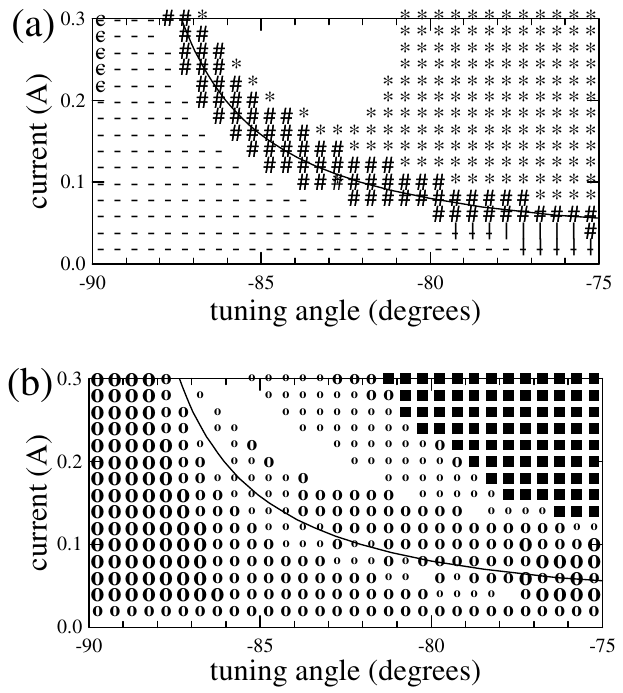
FIG. 4. Modeling for the Aladdin low-emittance lattice with worst-case parasitic coupled-bunch instability. A curve shows parameters for optimal bunch lengthening. (a) Analytic predic- tions. –: parasitic coupled-bunch instability; |: coupled-dipole Robinson instability; *: coupled-quadrupole Robinson instabil- ity; #: fast dipole-quadrupole mode-coupling Robinson instabil- ity; c: coupled-bunch instability with longitudinal mode number of 1. (b) Results of 500 000-turn simulations of 60 000 macro- particles. o: mild instability, where the energy spread exceeds its natural value by (10–30)%; o : moderate instability, where the energy spread has increased by (30–100)%; O : strong instability, where the energy spread has increased more than 100%; (cid:1) : lost